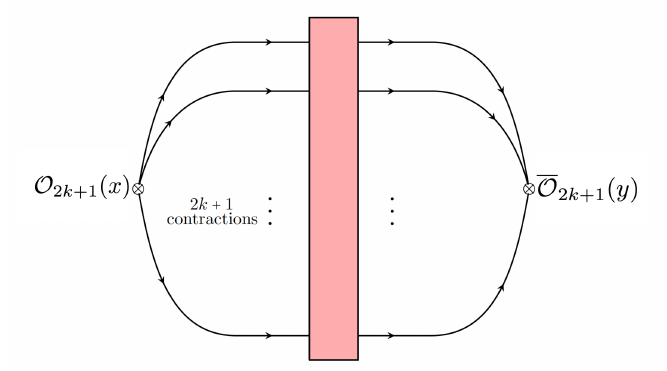
Figure 4 . When the effective vertex of figure 3 is used in the contraction of the (2 k +1) legs, one gets the first perturbative contribution to the 2-point function G 2 k +1 proportional to ζ (4 k + 1) λ 2 k +1 , as given in (3.5).